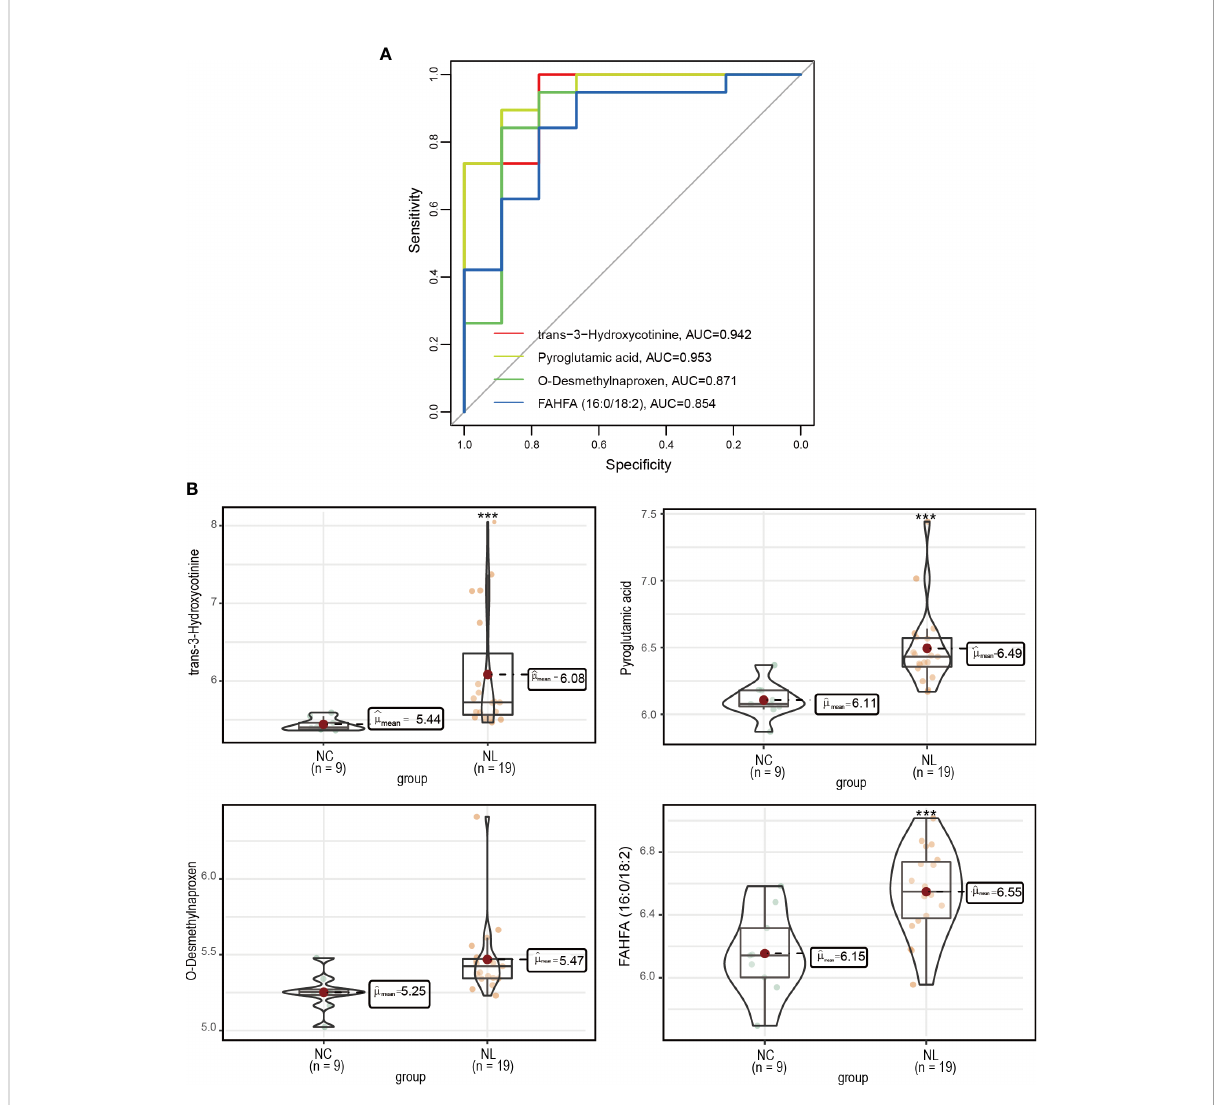
FIGURE 4 Measurement of potential biomarkers. (A) Performance assessment of nephrolithiasis prediction base on trans-3-hydroxycotinine, pyroglutamic acid, O-desmethylnaproxen and FAHFA (16:0/18:2) levels. (B) The concentrations of trans-3-hydroxycotinine, pyroglutamic acid, O-desmethylnaproxen and FAHFA (16:0/18:2) between control individuals and nephrolithiasis patients. Normal control (NC), nephrolith (NL). ***P <